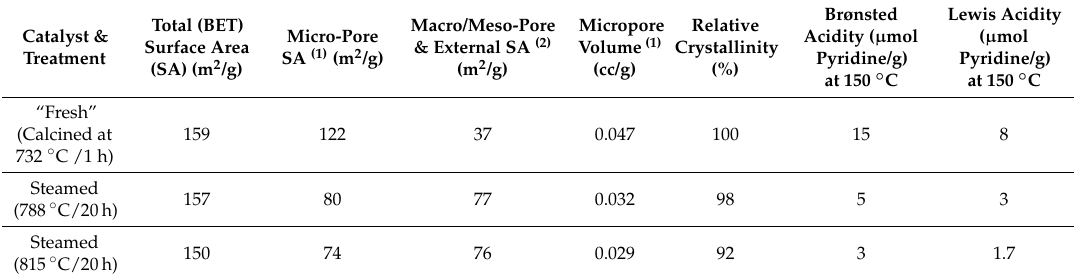
Table 1. Porosity, crystallinity, and acidity characteristics of the fresh and steamed P/ZSM-5 additives.